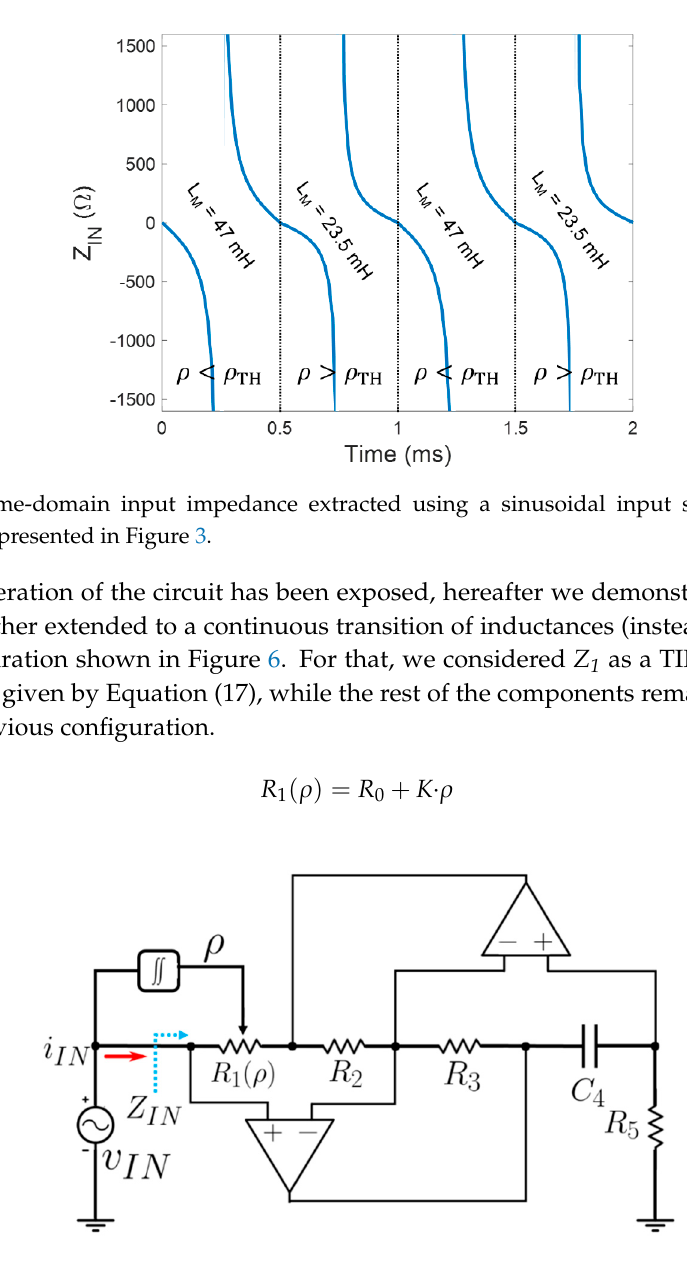
Figure 6. Schematic circuit for the continuous states meminductor emulator.